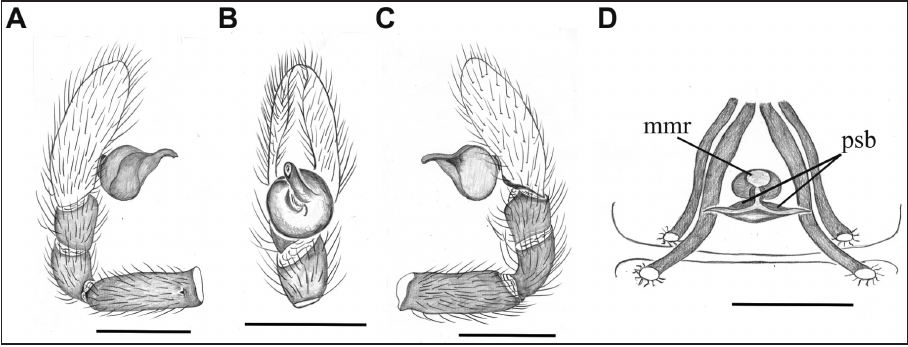
Figure 16. Carajas paraua sp. n. , male from IBSP 161191 ( A–C ) and female from IBSP 191285 ( D ). A left pedipalp, prolateral view B same, ventral view C same, retrolateral view D internal genitalia and tracheae tubes, dorsal view (mmr = membranous anteromedian receptaculum; psb = pair of sclerotized bars). Scale bars: A–D 0.5